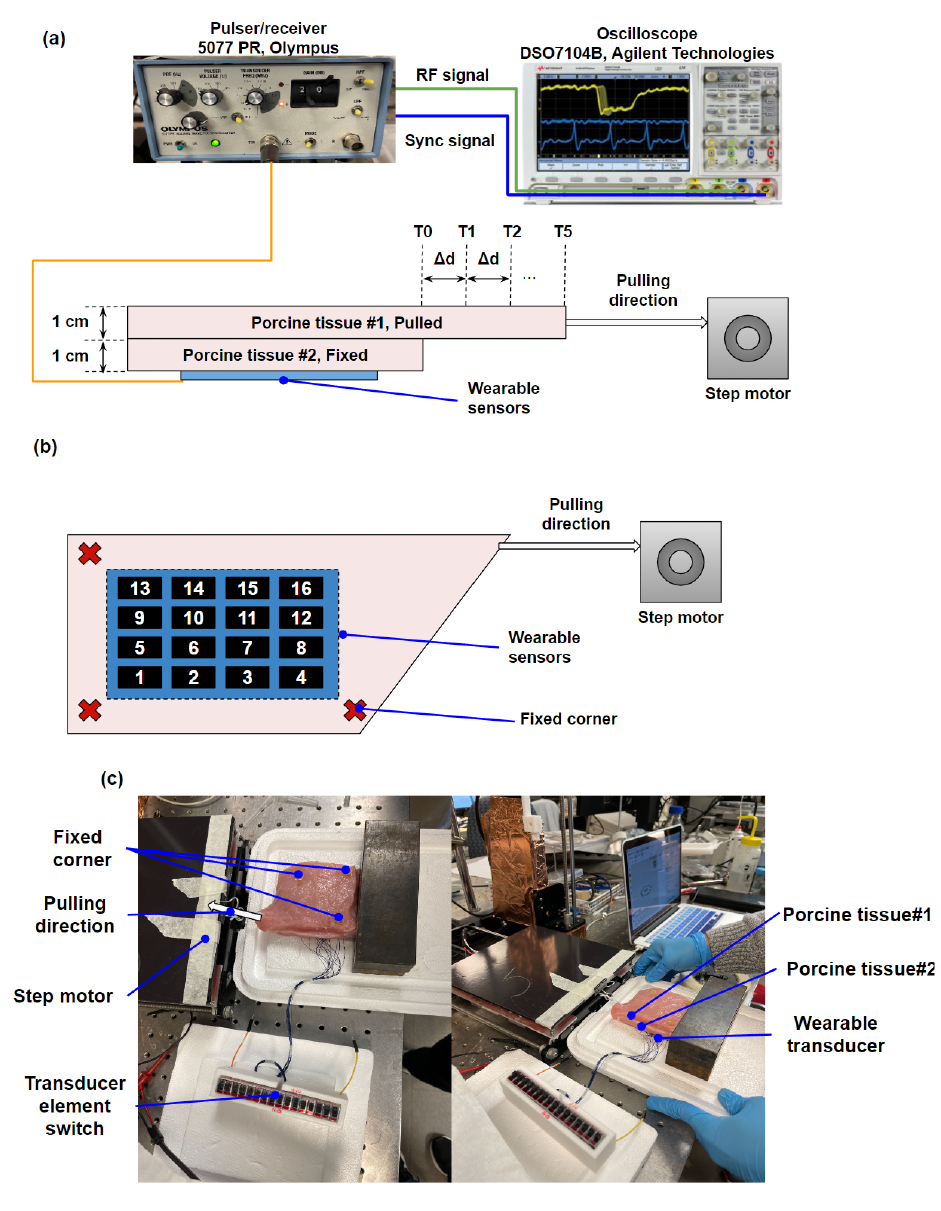
Figure 5. Experimental setup for in vitro test: block diagrams of the experimental system: ( a ) side view and ( b ) top view; ( c ) photographs of the experimental